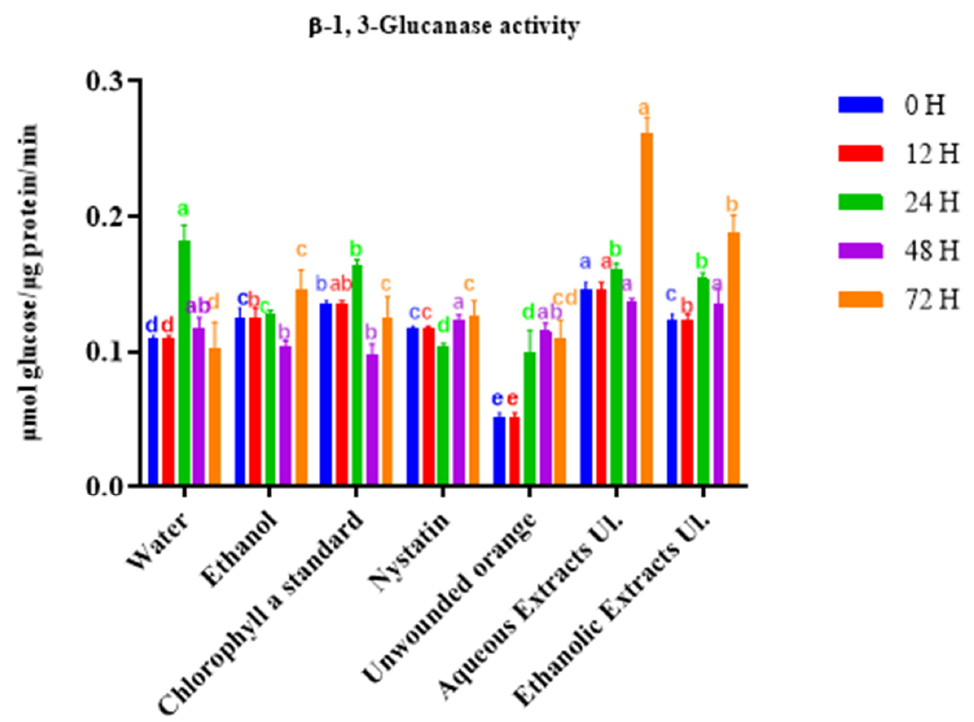
Figure 3. Enzymatic activity of β -1,3-glucanase in orange tissues treated with ethanolic or aqueous extracts of Ulva lactuca . Tissues were sampled up to 72 h. For each timepoint, columns (treatments) with different letters are significantly different: p < 0.05 (Duncan’s test).